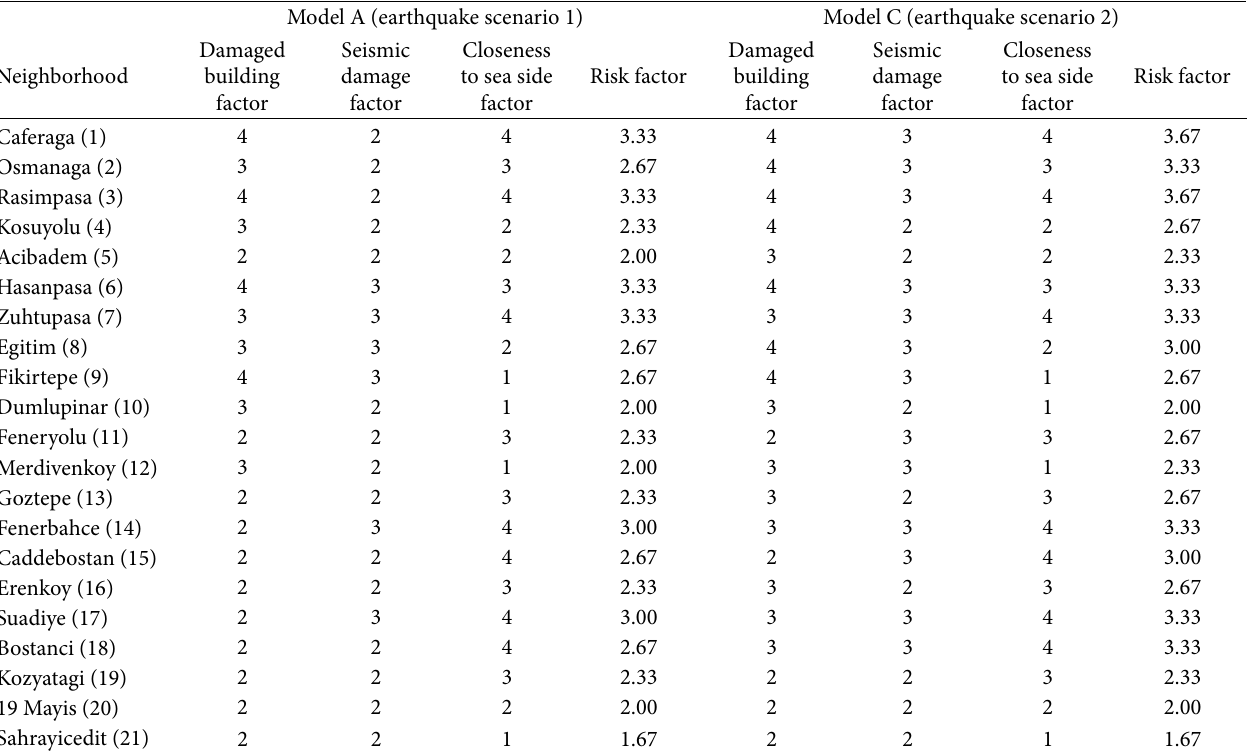
Table 2: Risk factors of neighborhoods of Kadiköy municipality for model A (earthquake scenario 1) and C (earthquake scenario 2).